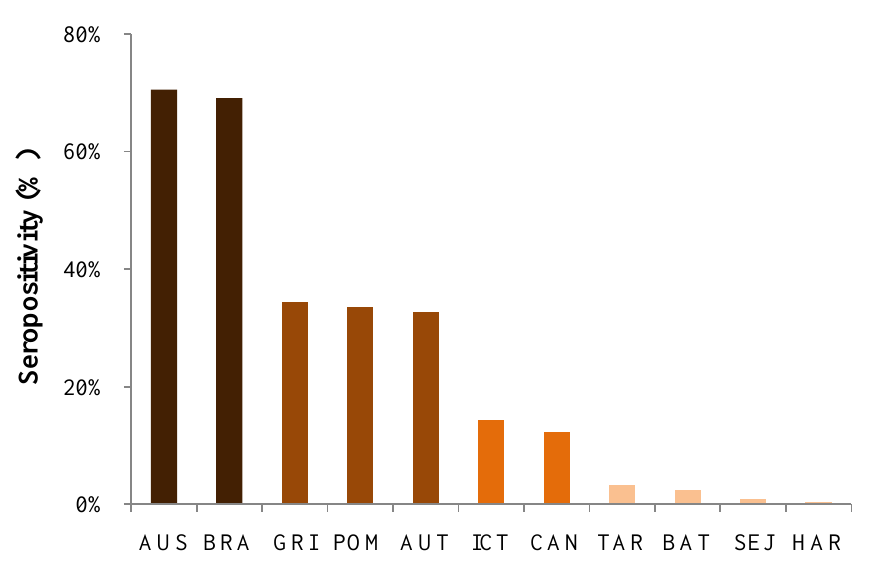
Figure 2. MAT seropositivity for 11 serovars tested in 259 dogs diagnosed with leptospirosis in